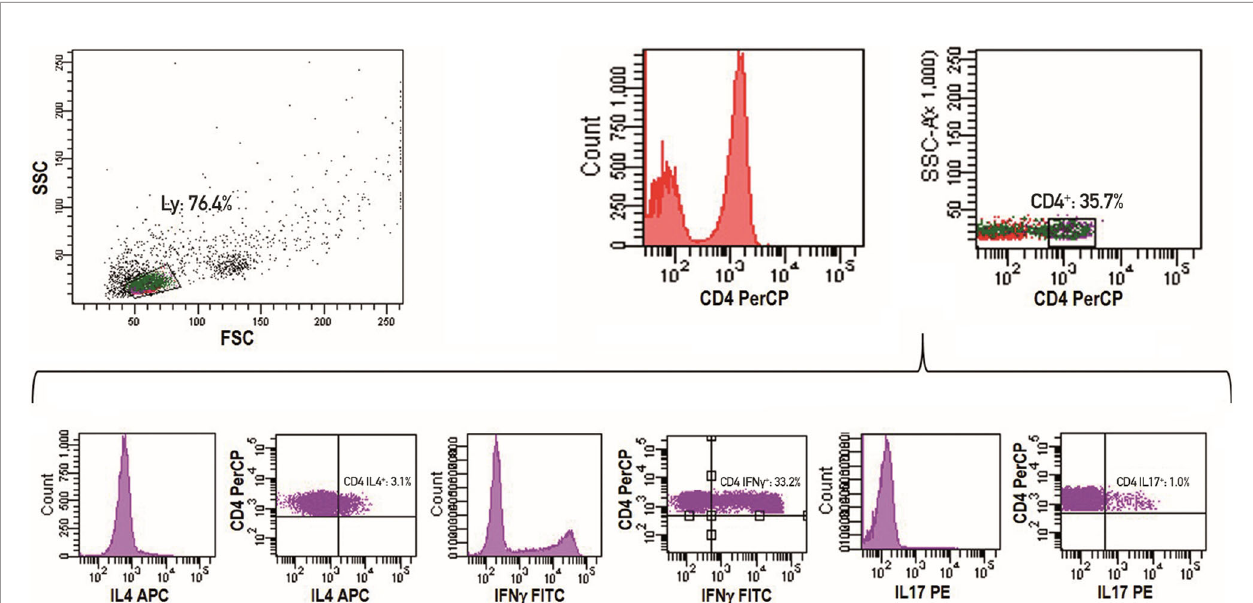
FIGURE 1 | Representative example of a fl ow cytometry experiment. Lymphocytes are initially gated according to forward and side scatter features. An additional gate for CD4+ cells is established. The Th2, Th1 and Th17 cells results are reported as percentages of CD4+ lymphocyte